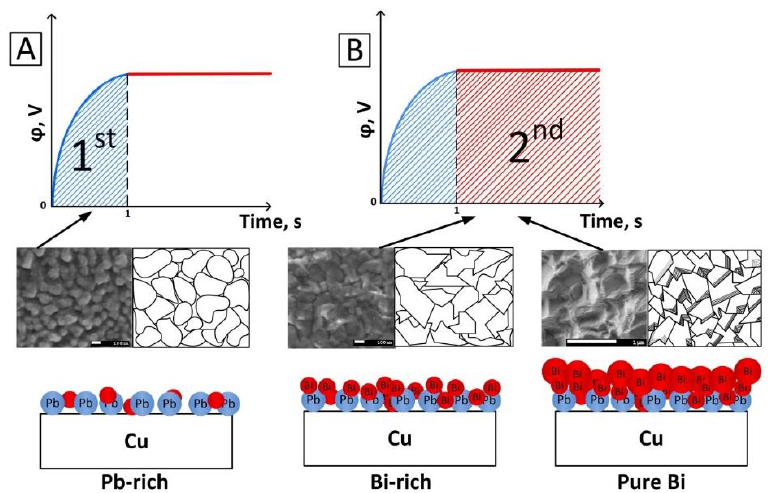
Figure 9. The main stages and growth mechanisms of Pb:Bi and Bi films electrodeposited from PE in the galvanostatic regime. A —the co-deposition of Pb and Bi (the 1 st stage), B —Bi electrodeposition (the 2 nd stage).